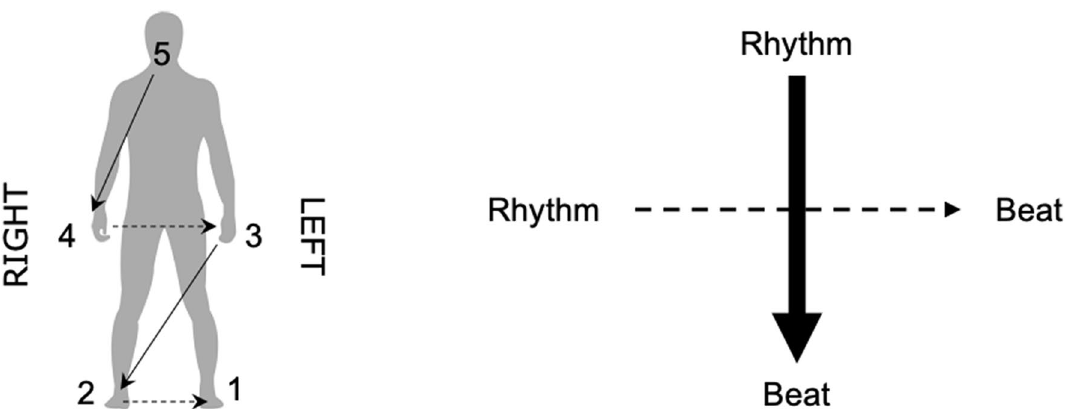
Figure 8. The bodily hierarchy. The bodily hierarchy pertaining to right-handed participants encompasses the following components: (1) left foot—(2) right foot—(3) Left hand—(4) Right hand—(5) voice. As indicated by the arrows, the hierarchy has a horizontal and a vertical dimension of which the vertical dimension precedes the horizontal. Figure was created using Adobe Illustrator 2018 22.0.0 (https:// www. adobe. com/ produ cts/ illus trator. html) and Microsoft Word for Mac, version 16.49 (21,050,901) (https:// www. micro soft. com/ da- dk/ micro soft- 365/